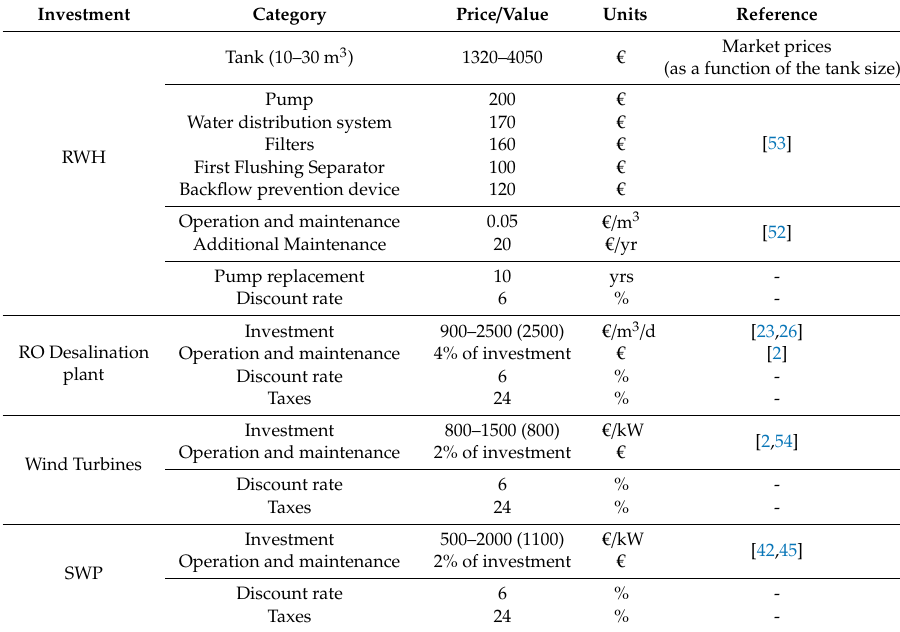
Table 3. Investment and operation